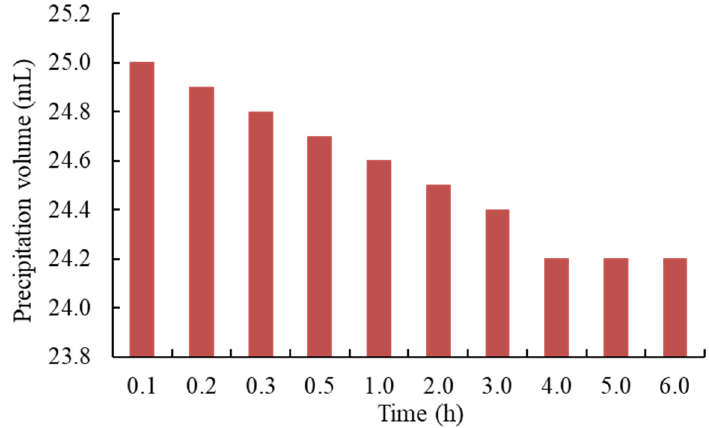
Figure 6. Precipitation volume of the plugging agent solution versus time.